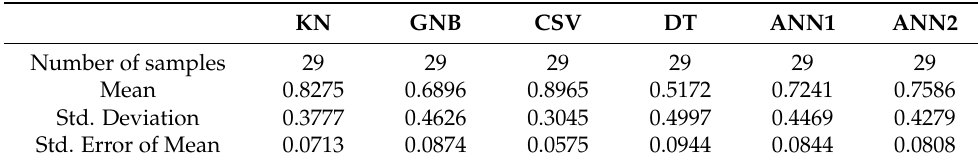
Table 4. Descriptive statistics by classifier; KN: K-Neighbors; GNB: Gaussian Naive Bayes; CSV: C-Support Vector; DT: Decision Tree; ANN1: Artificial neural network with a single hidden layer; ANN2 Artificial neural network with two hidden layers. KN GNB CSV Number of samples